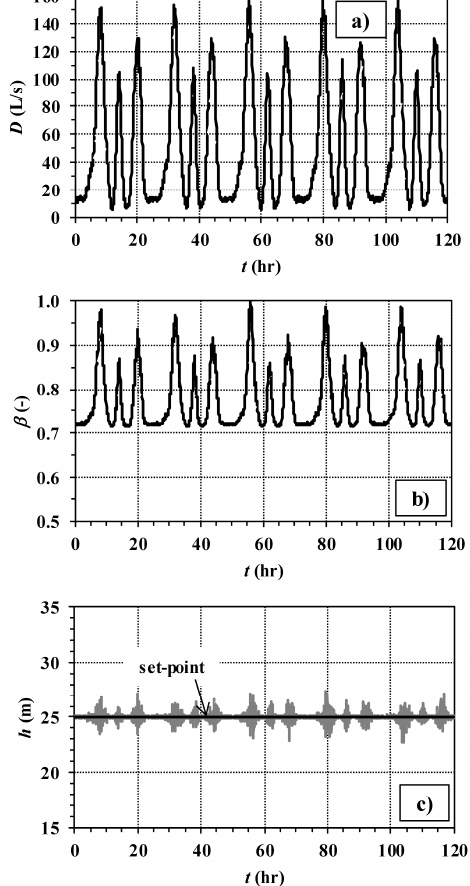
Figure 5. RTC of variable speed pump through LCb. In the five days of network operation, trends of total network demand ( a ), device setting ( b ) and controlled pressure head ( c ).